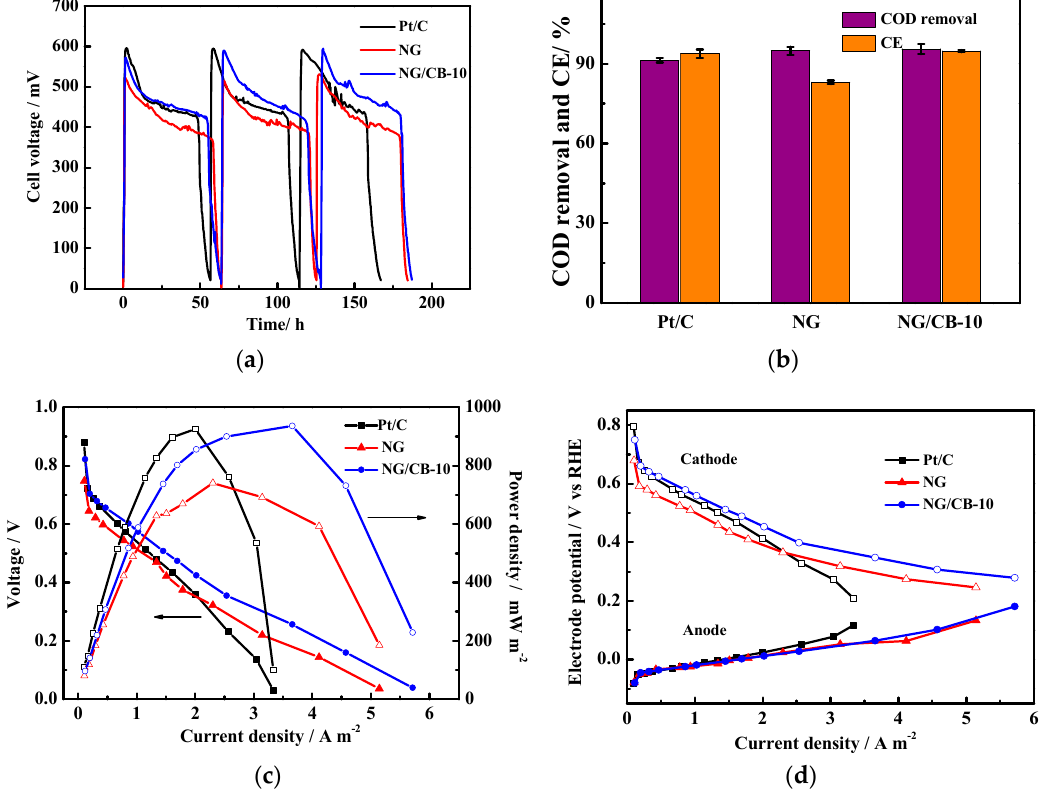
Figure 6. The voltage-time profile ( a ): external resistance of 1000 Ω and temperature of 30 ± 1 °C, COD removal and coulombic efficiency ( b ), polarization and power density curves ( c ) and electrode potentials ( d ) of MFCs equipped with different cathode electrocatalysts. Power generation is one of the most significant evaluation parameters of MFC